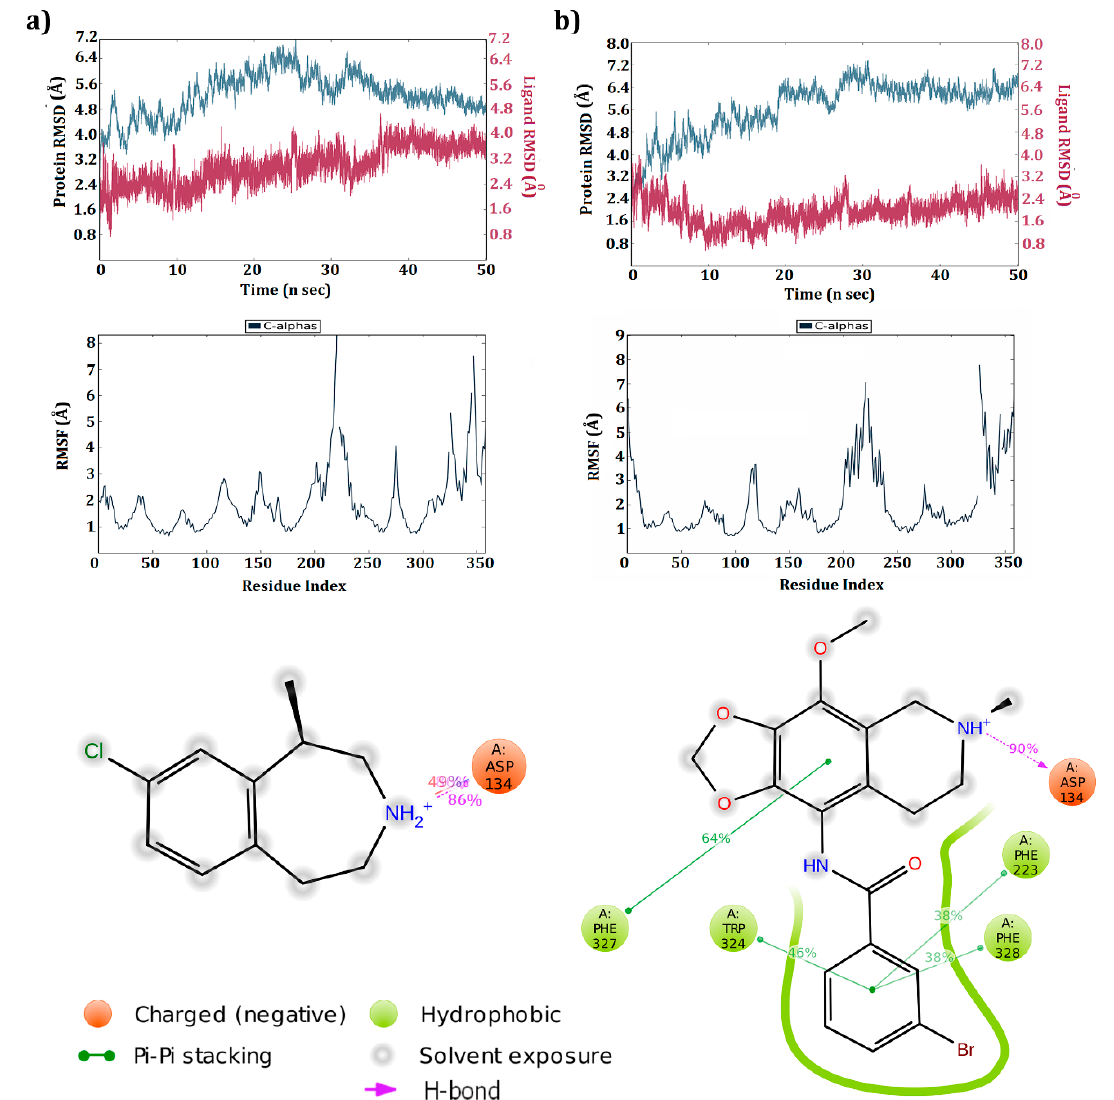
Figure 3. The 5HT 2C receptor and molecules complex deviation, fluctuations, and interaction percentage at the end of simulation study: ( a ) Receptor—Lorcaserin; ( b ) Receptor—ZINC32123870.